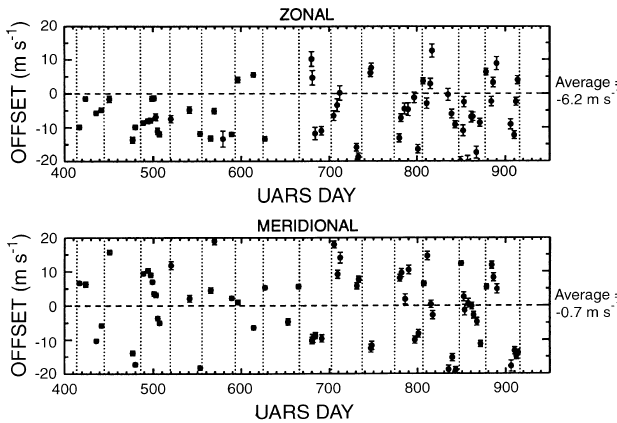
Fig. 7. WINDII/HRDI wind-speed ratios ( upper panel ) and direc- tion di(cid:128)erences ( lower panel ) for an altitude of 95 km obtained with the histogram method